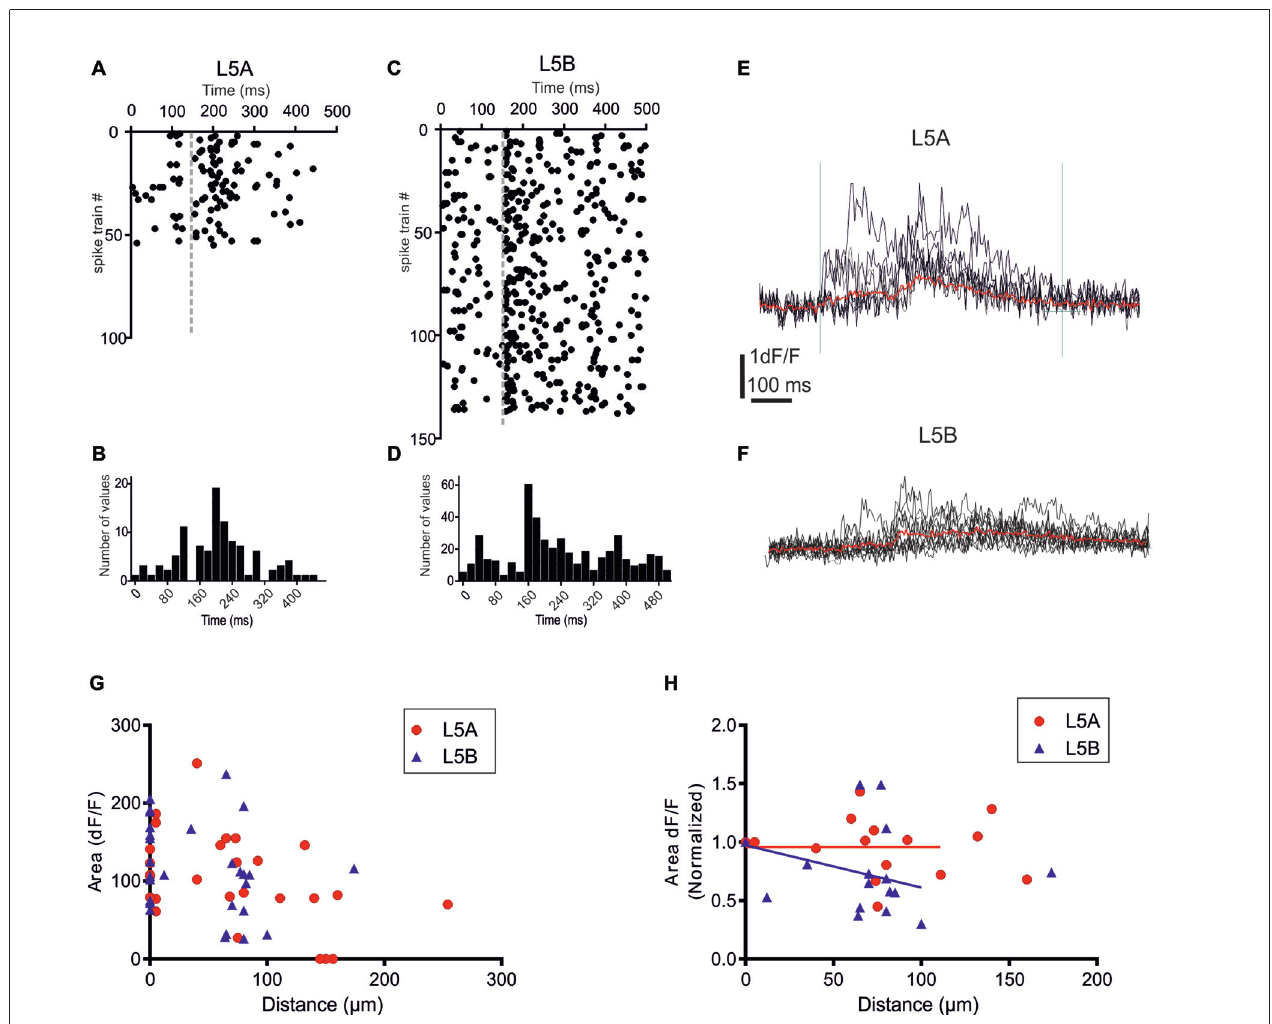
FIGURE 2 | bAP-evoked calcium responses evoked by physiological spike trains action potential (AP) patterns. (A) A raster plot showing 55 different in vivo recorded spike trains recorded from six L5A-st pyramidal cells. (C) The corresponding 138 spike trains recorded from six L5B-tt pyramidal cells. (B,D) Summary histograms showing the temporal structure of the L5A-st and L5B-tt spike trains, respectively. (E) An example of the bAP-evoked calcium response evoked in a L5A-st cell by seven different in vivo recorded spike trains. As illustrated by the two vertical lines (left line marks the time of the first AP in the spike train, and the right line is at +600 ms) the calcium response was quantified by calculating the integral of the d F / F ( t ) function with t = 600 ms. The red sweep shows the average response. (F) An example of the bAP-evoked calcium response evoked in a L5B-tt cell (at 35 µ m) by 10 different in vivo recorded spike trains. The red sweep shows the average response. (G) The average calcium response evoked by in vivo AP pattern stimulations. The bAP-evoked calcium response is plotted as a function of distance along the basal dendrite. (H) The bAP-evoked response normalized separately for each branch to the response at the proximal dendrite location (distance < 10 µ m). Linear regression (for points up to 125 µ m) shows that for L5B-tt ( P = 0.0412) but not for L5A-st ( P = 0.3257) the slope deviates from zero, thus suggesting that in L5B-tt, but not in L5A-st the bAP-evoked response decreases at distal points (up to 125 µ